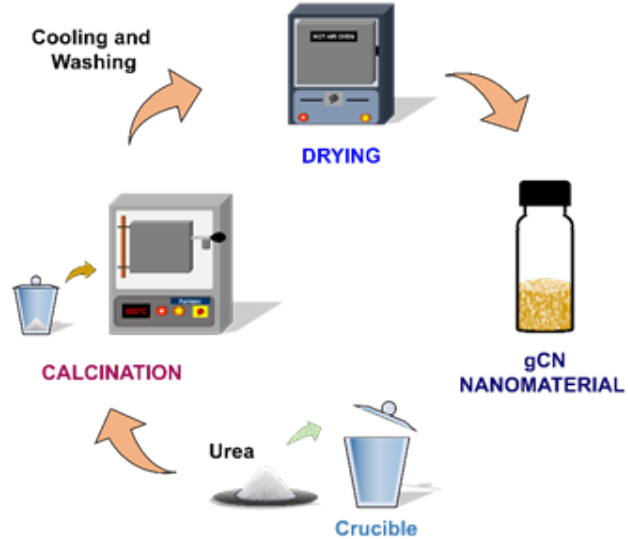
Figure 2. Schematic representation of gCN